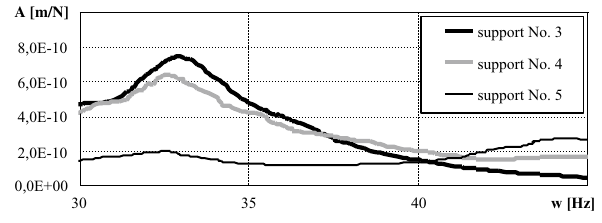
Fig. 12 Dependence of the displacement amplitudes of the forced oscillations of the supports No. 3, 4, 5 on the frequencies for the model 10 (basic with a low degree of